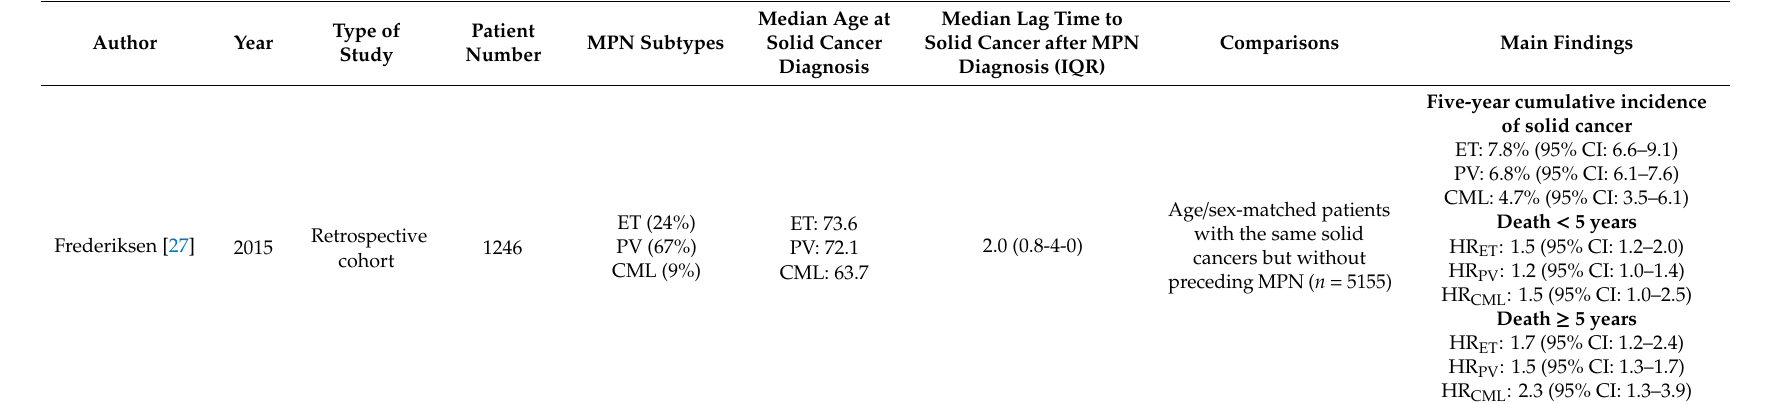
Table 3. Prognosis in patients with chronic myeloproliferative neoplasms (MPNs) after diagnosis of a new primary solid